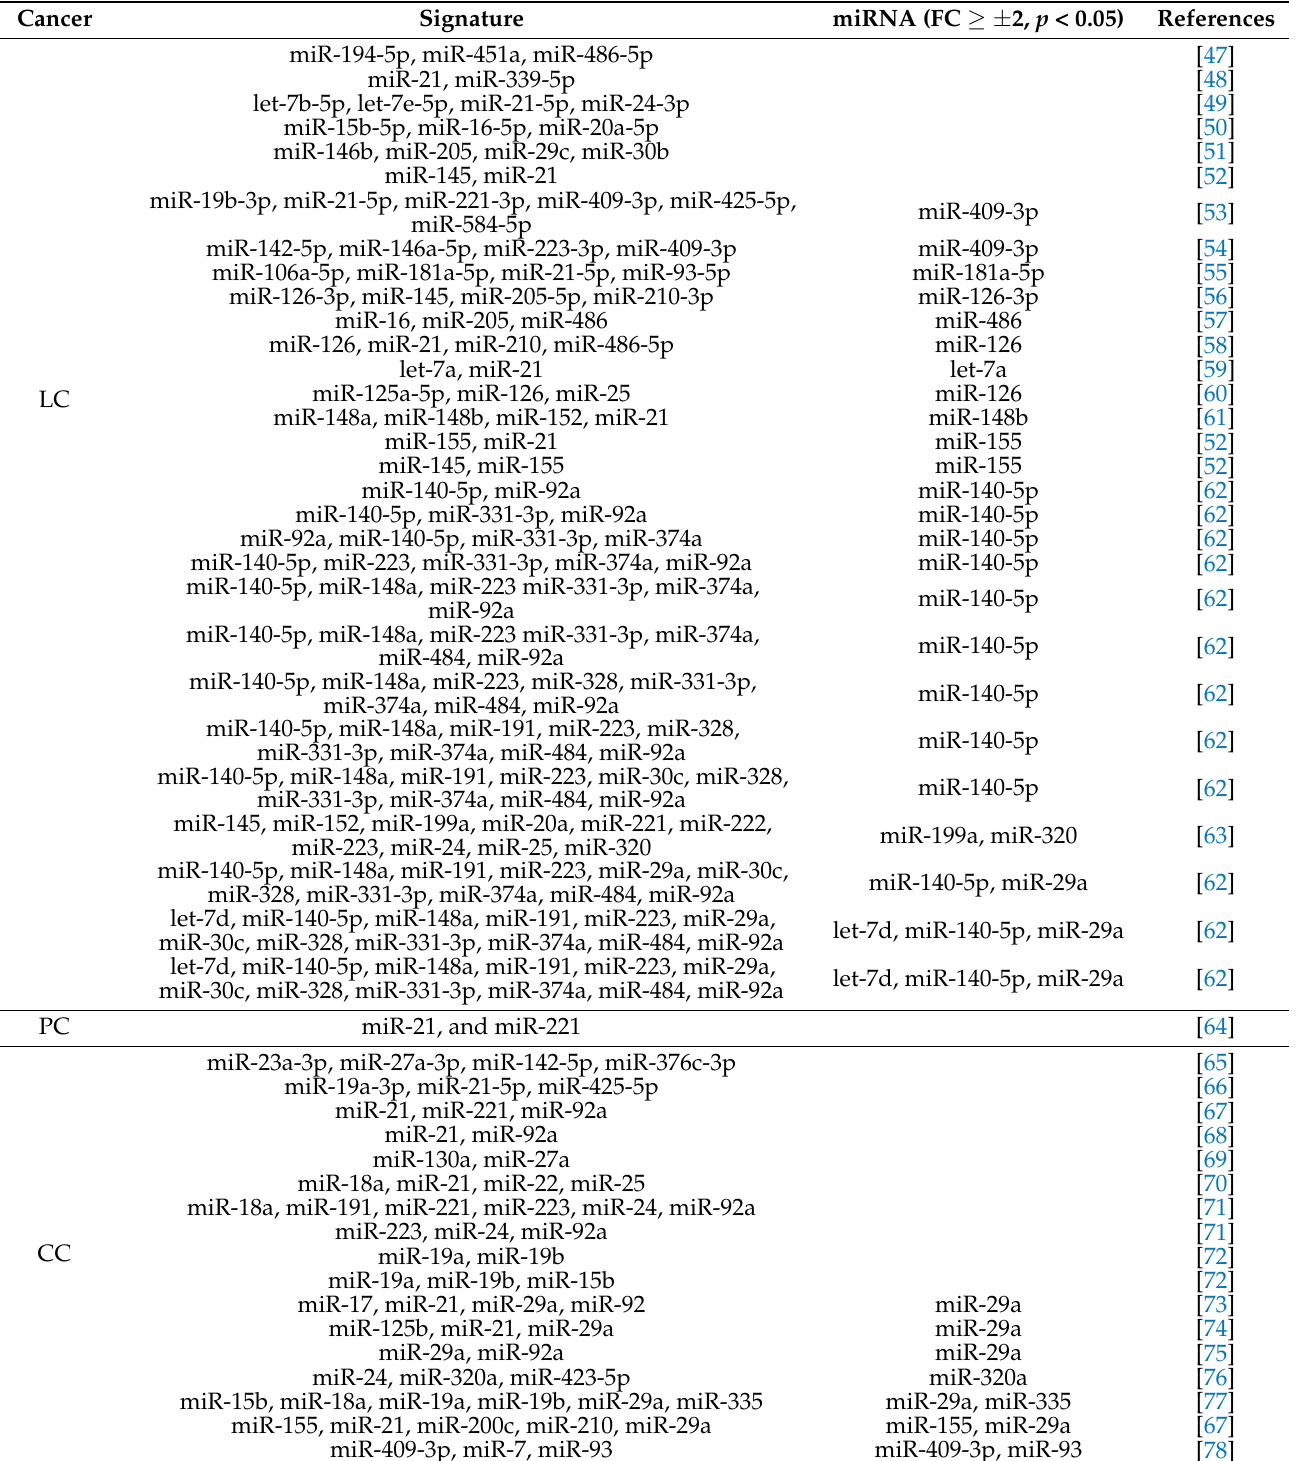
Table 3. List of diagnostic signatures for lung (LC), prostate (PC), colon (CC), liver (HC) and gastro-esophageal (GEC) cancers that include miRNAs significantly ≥ 2-fold up- or downregulated in trained subjects compared to sedentary subject ( p -value <